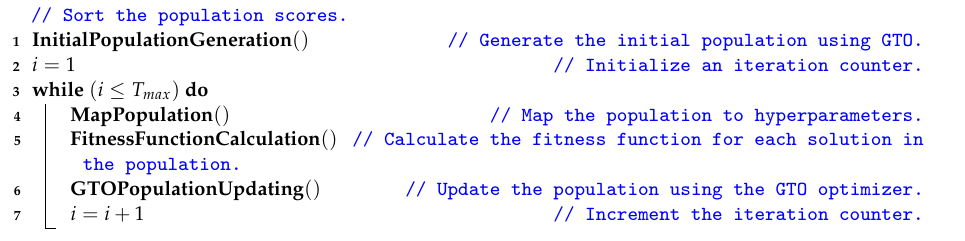
Algorithm 1: The hyperparameters optimization overall process in